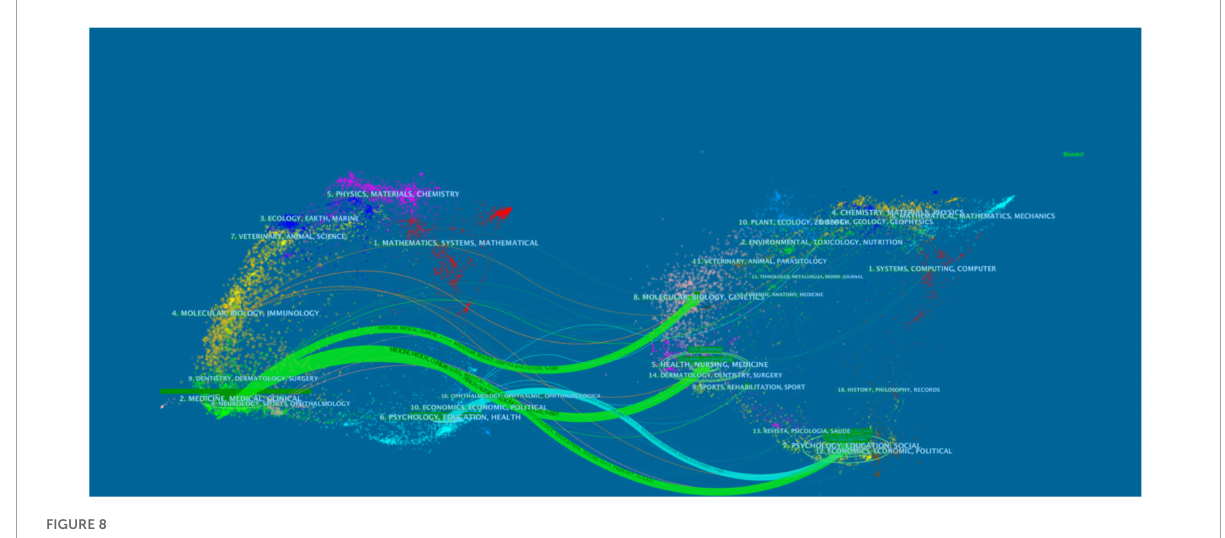
FIGURE8 Dual-map overlay of journals on